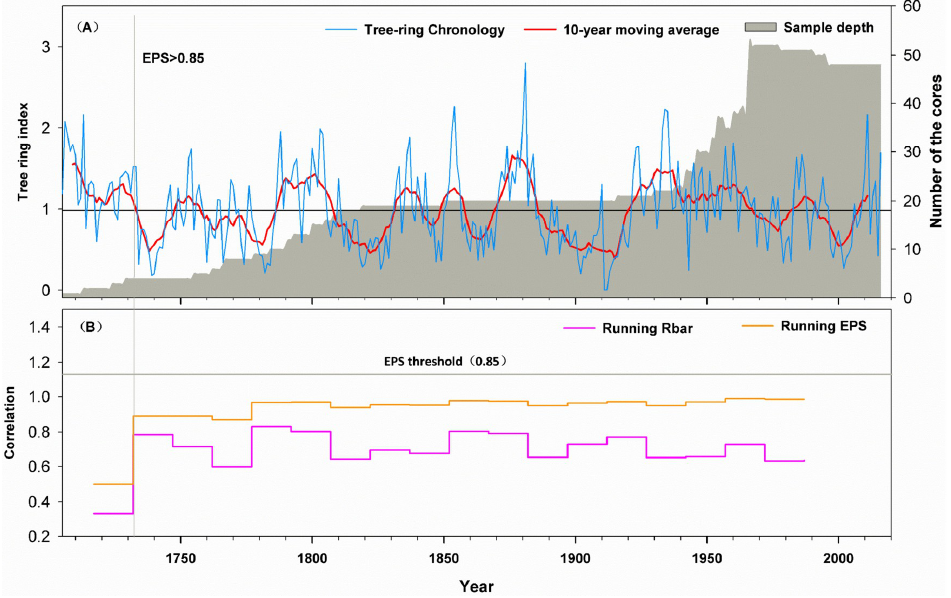
Figure 2. ( A ) The regional tree-ring standard chronologies and sample depth. ( B ) The running Rbar (30-year window lagged 15 years) and the running expressed population signal (EPS). The reliable portion of the chronology has running EPS value >0.85.